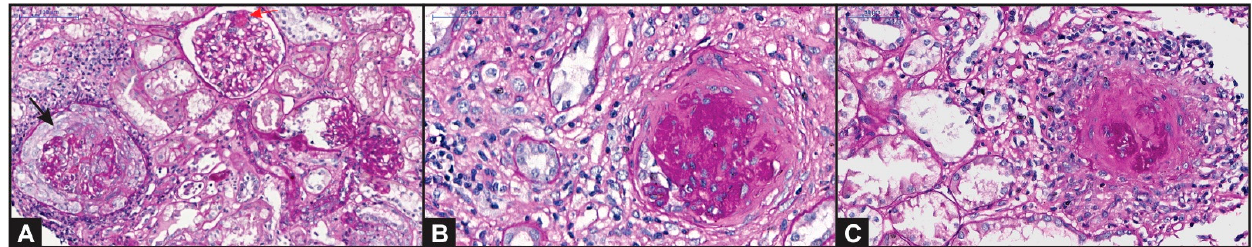
Figure 2. Kidney biopsy showing: ( A ) a circumferential cellular crescent producing compressive effect on glomerular tuft (black arrow). Some remaining glomeruli maintain their normal structure or segmental sclerotic lesions (red arrow)— Periodic Acid-Shiff (PAS); ( B ) a sclerotic crescent surrounding a sclerotic glomerulus (PAS); ( C ) mononuclear inflammatory cells around a glomerulus with capsule rupture, revealing a “granulomatous-like” or “sunburst” aspect